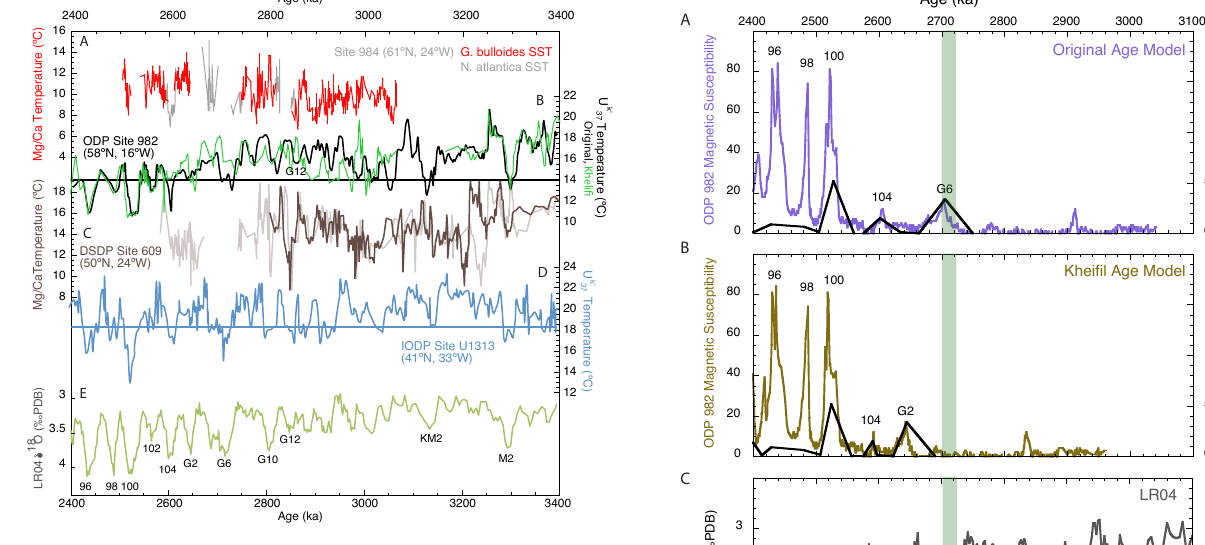
Fig. 6. Pliocene North Atlantic sea surface temperature data: (A) ODP Site 984 Mg/Ca SST (red=G. bulloides, light gray=N at- 0 lantica) (Bartoli et al., 2005), (B) ODP Site 982 U K SST (Lawrence 37 et al., 2009) on the original age model (black) (Lisiecki and Raymo, 2005) and the revised age model (green) (Khelifi et al., 2012), (C) DSDP Site 609 Mg/Ca SST (light brown) (Bartoli et al., 2005) and revised age model (dark brown) (see Supplement), and (D) ODP 0 Fig. 7. Site 982 ice-rafted debris (Baumann and Huber, 1999) and Site U1313 U K SST (dark blue) (Naafs et al., 2012). (E) LR04 37 magnetic susceptibility data (black) (Shipboard Scientific Party, global benthic stack (light green) (Lisiecki and Raymo, 2005) with 1996) plotted on (A) the original age model (purple) (Venz and significant glacial marine isotope stages labeled in black. Horizon- Hodell, 2002) and (B) the age model proposed by Khelifi et tal lines in (B) and (D) denote average Holocene SST for Site 982 al. (2012) (brown). (C) Benthic oxygen isotope data from the LR04 and Site U1313. global benthic stack (Lisiecki and Raymo, 2005) (gray). The ver- tical green bar highlights the onset of major IRD deposition in the northeast North Atlantic Ocean. Significant glacial marine isotope states are labeled in